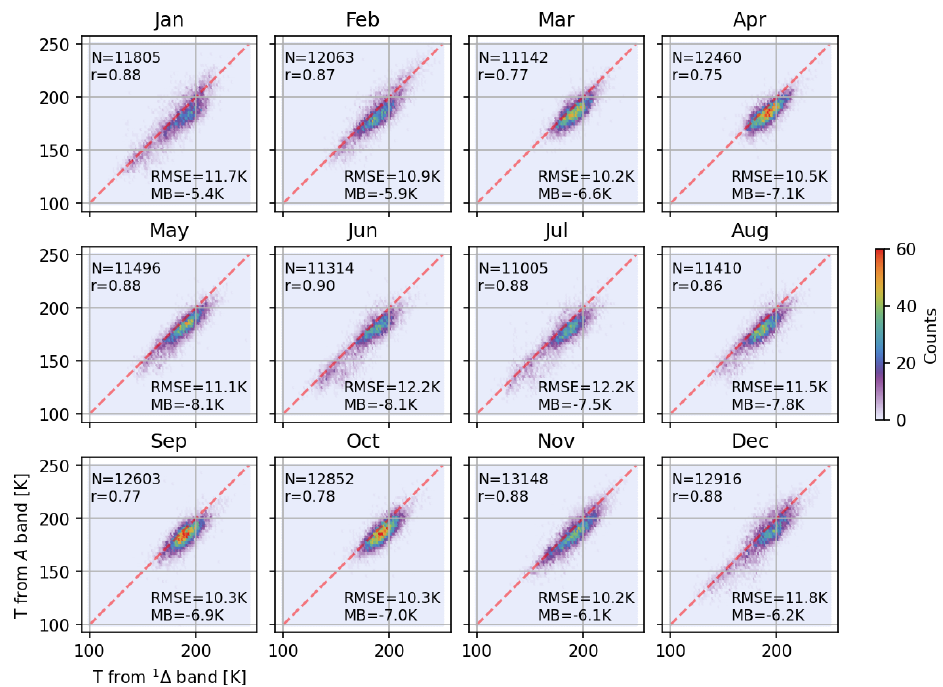
Figure 14. Comparisons between temperatures retrieved from 1 (cid:49) - and A -band airglow over the mesopause region. Each panel includes all MLT orbits in each month of